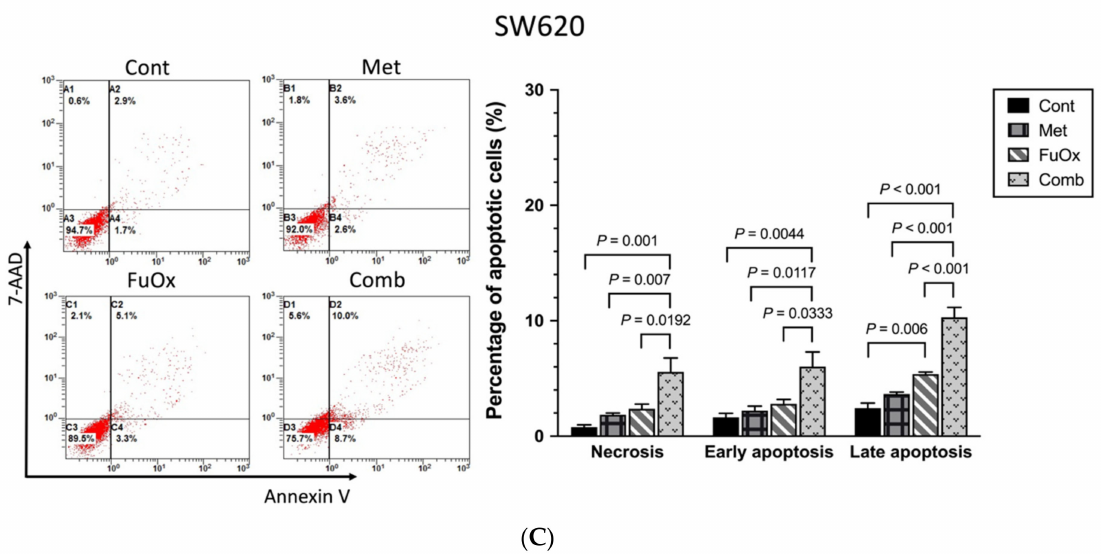
Figure 4. The combination therapy group induced greater apoptosis than metformin alone and FuOx alone groups in HT29, SW480, and SW620 cell lines. CRC cells were analyzed using flow cytometry after 72 h of treatment with metformin (5 mM), FuOx (2 µ M), and the combination of metformin and FuOx. Representative flow cytometry dot plots ( left panel) and histograms ( right panel) reveal cell apoptosis and quantitative analysis, respectively, for ( A ) HT29, ( B ) SW480, and ( C ) SW620 cell lines. Data are presented as mean ± SEM. Cont, control; Met, metformin; FuOx, 5FU and oxaliplatin; Comb, combination of metformin and